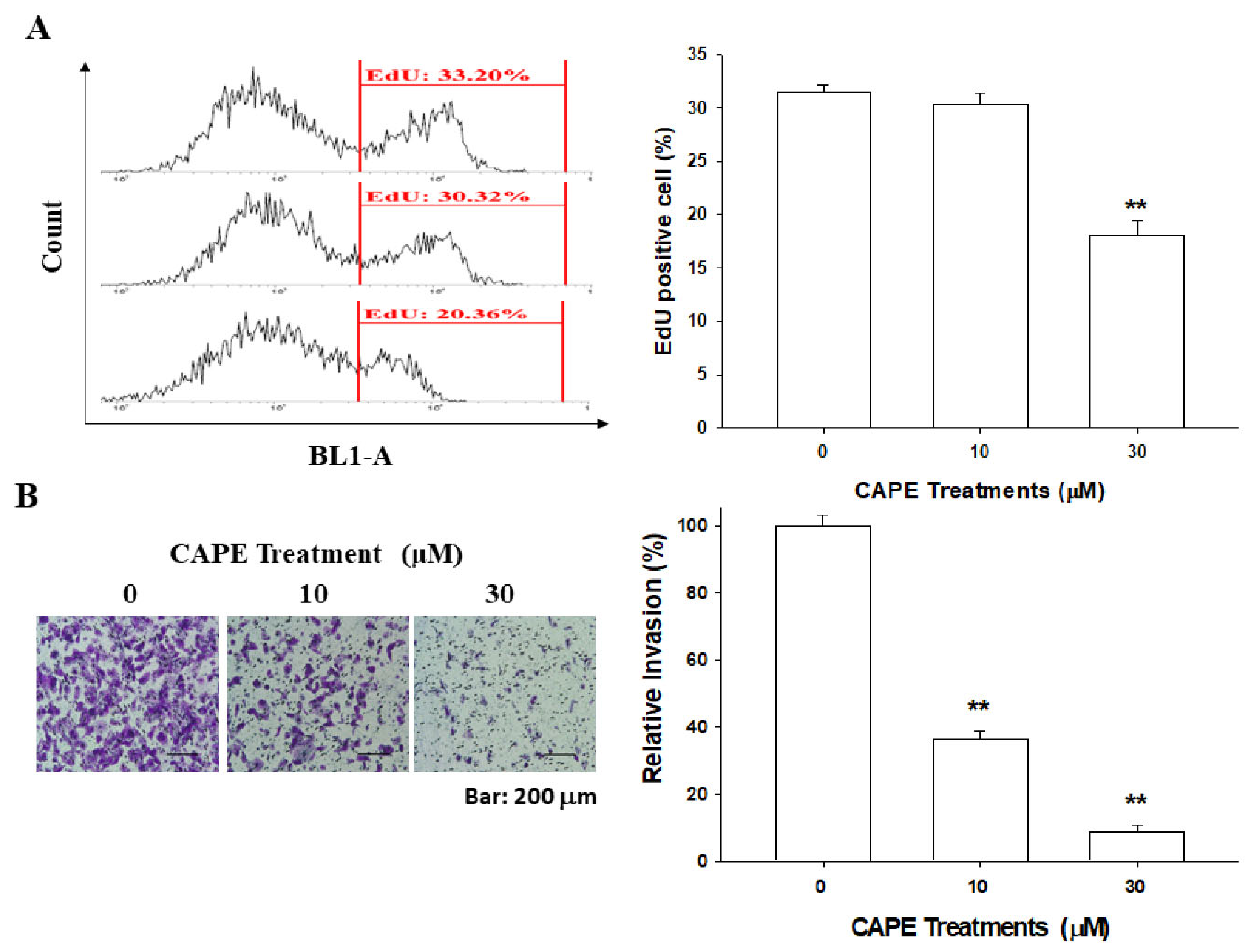
Figure 4. Effects of CAPE on cell proliferation and invasion in AR − negative PC-3 cells. ( A ) The proliferation ability of PC-3 cells after treatment with various concentrations of CAPE as indicated for 24 h was determined through flow cytometry by using the Click-iT EdU flow cytometry kit ( ± SE, n = 4). ( B ) The invasion ability of PC-3 cells after treatment with various concentrations of CAPE as indicated for 24 h was determined through in vitro Matrigel invasion assays ( ± SE, n = 3). The bar line represents 200 µ m. Data are presented as mean percentage of reporter activity ( ± SE, n = 6) compared with the vehicle-treated group. ** p < 0.01.